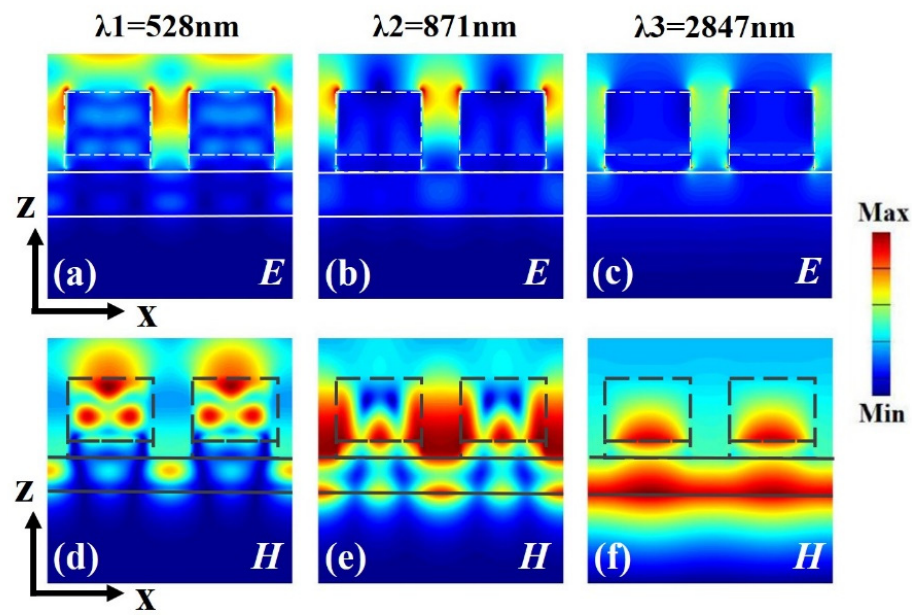
Figure 3. Distribution of the electric ( a – c ) and magnetic ( d – f ) fields inside the absorber.